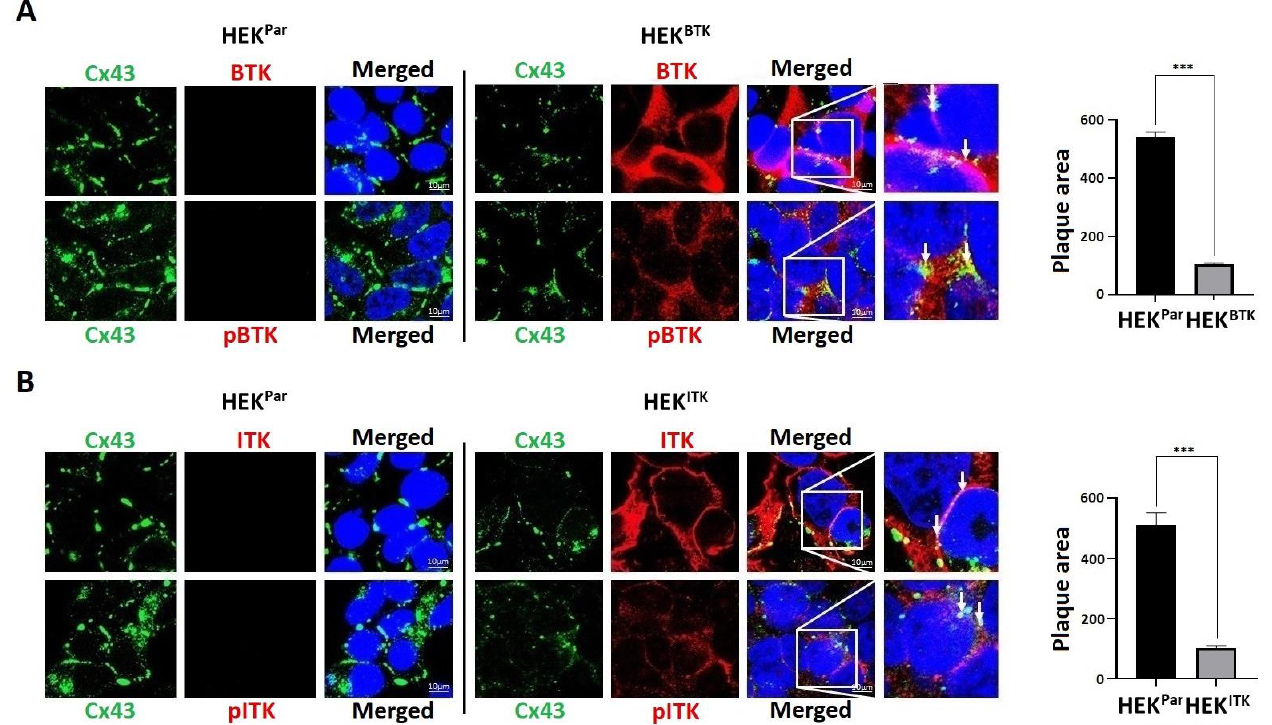
Figure 4. Cellular localization of endogenous Cx43 in the HEK-293T cells overexpressing active BTK or ITK. Immunofluorescence was performed to visualize Cx43 in the HEK-293T cells stably express- ing ( A ) BTK (HEK BTK ) or ( B ) ITK (HEK ITK ). HEK-293T parental (HEK Par ) cells were used as the control (Green, Cx43; Red, BTK/pBTK or ITK/pITK; Blue, DAPI; white arrows show colocalization with Cx43). Surface area of the plaques was measured on ImageJ (all units were measured in pixels) and quantified using GraphPad Prism by Student’s t -test ( n = 10, *** p < 0.001).